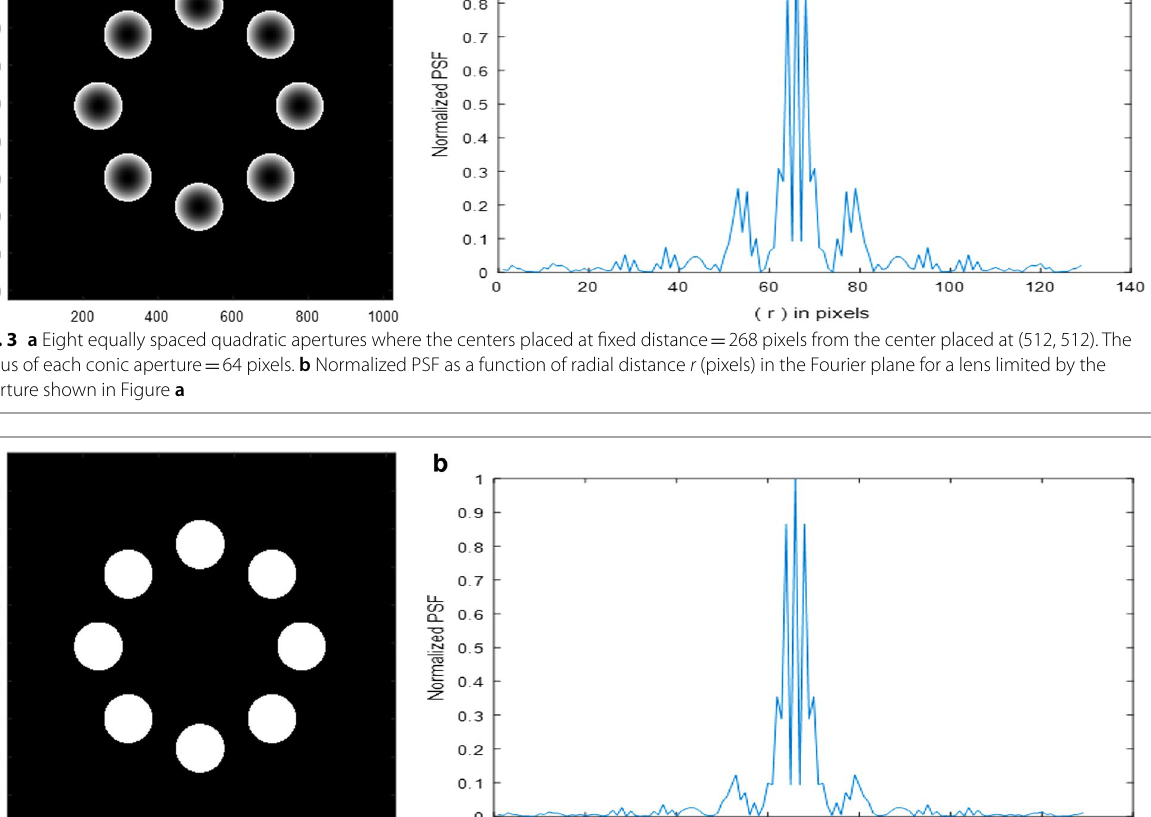
Fig. 4 a Eight equally spaced uniform circular apertures where the centers placed at fixed distance 512). The radius of each conic aperture 64 pixels. b Normalized PSF as a function of radial distance r (pixels) in the Fourier plane for a lens limited = by the aperture shown in Figure a